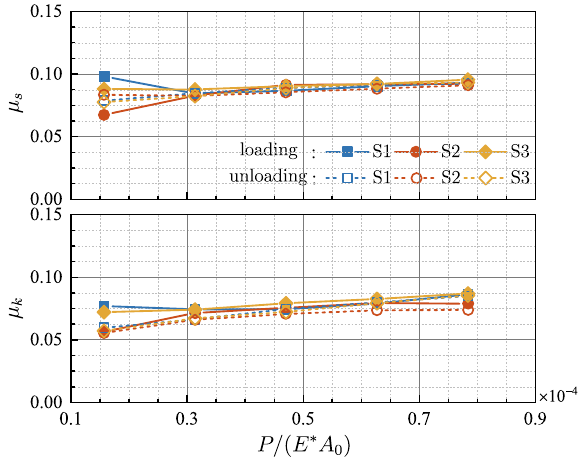
Figure 8. Evolution of the friction coefficient with respect to the dimensionless normal load.